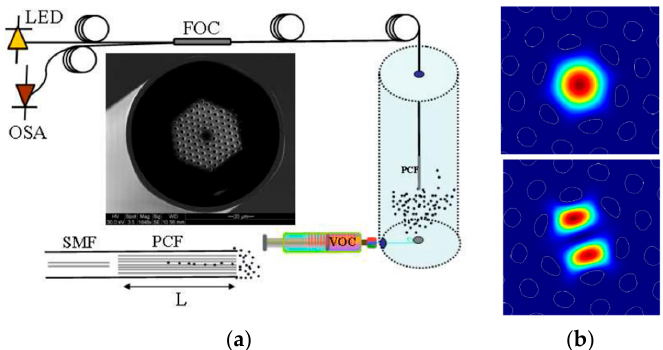
Figure 21. (a) Diagram of the experimental setup, micrograph of the SC-PCF used and drawing of the interferometer. L is the PCF length. LED stands for light emitting diode, FOC for fiber optic circulator or coupler, OSA for optical spectrum analyzer and SMF for single-mode fiber. The dots represent volatile organic compound (VOC) molecules; (b) transverse component of the electric field of the LP 01 - and LP 11 -like modes. Reprinted with permission from [130] ©2009 Optical Society of America. Using also an HC-PCF in reflection mode, B. Kim et al. developed the following sensor